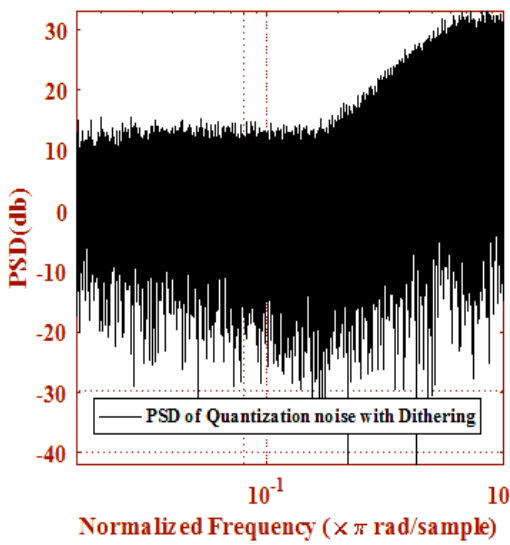
Figure 13. PSD of quantization noise with dithering.